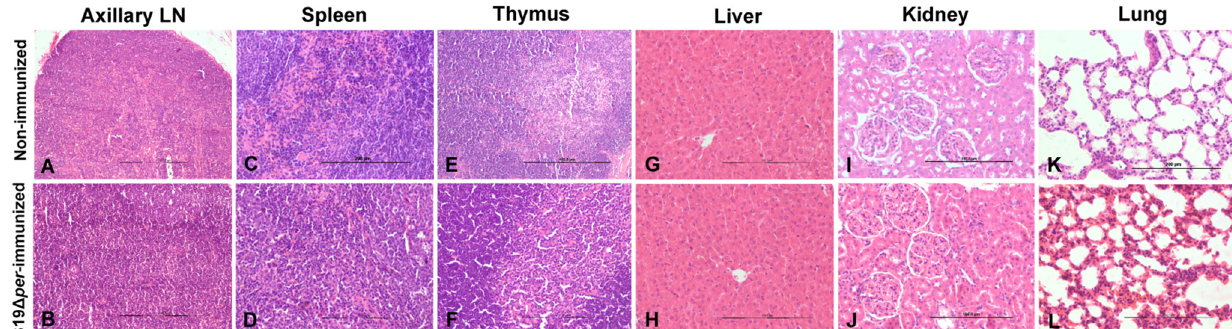
Figure 2. Histopathological lesions of vaccine safety assay in guinea pigs. ( A ) Axillary lymph node showed normal cortex and medullary areas. ( B ) Axillary lymph node showed lymphoid hyperplasia in cortex. ( C ) Spleen showed normal red and white pulp areas. ( D ) Spleen showed lymphoid hyperplasia in white pulp. ( E , F ) Thymus showed dark stained cortex and light stained medullary areas. ( G , H ) Liver showed normal architecture with hepatocytes arranged in radiating cords and normal sinusoidal space. ( I , J ) Transverse section of cortex of kidney showed normal glomeruli and proximal convoluted tubules. ( K , L ) Lungs showed normal alveoli lined by simple squamous epithelium. Tissue sections were stained with H&E staining and images were acquired at 100 × ( A , B , E ) and 200 × ( C , D , F – L ) magnifications using light microscope.